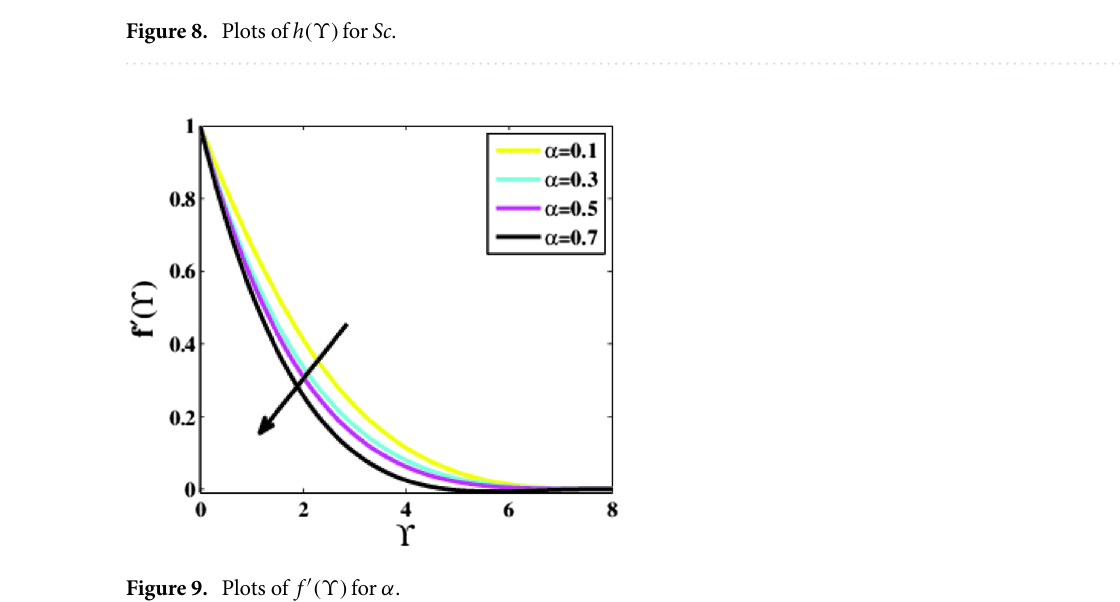
Figure 9. Plots of f